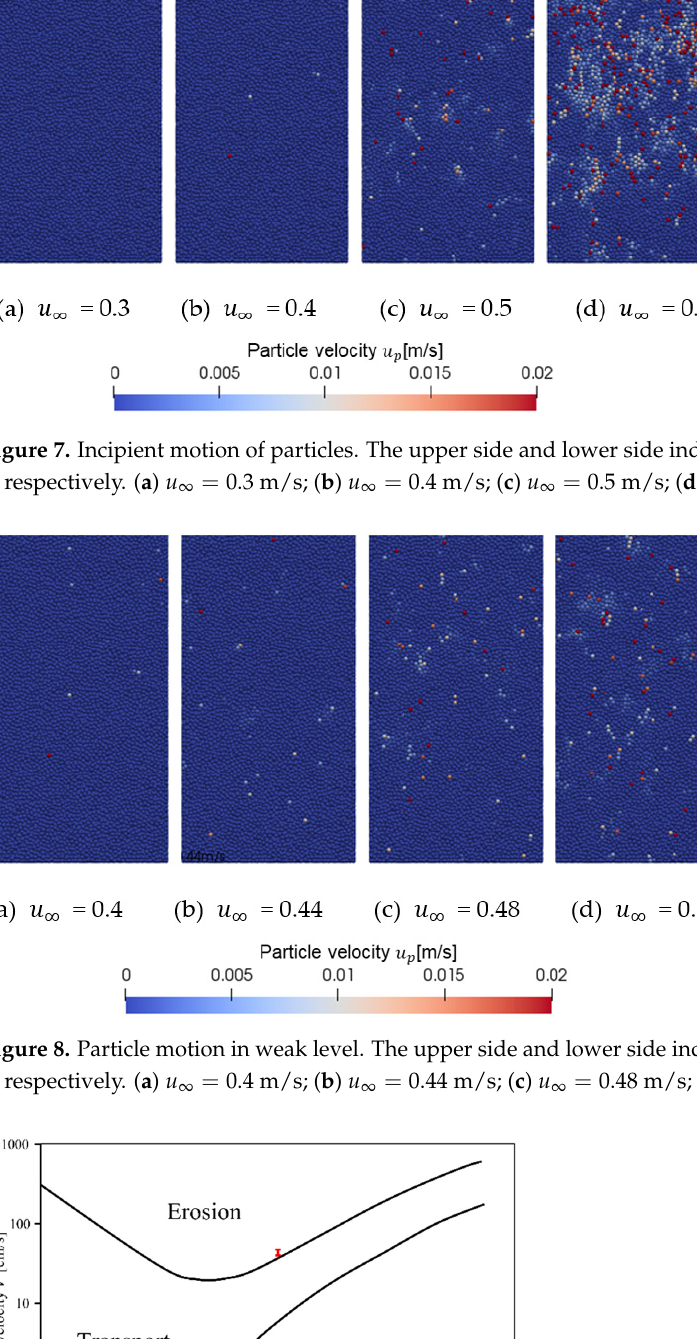
Figure 9. Simulation results for d p = 1 mm in the ranged from u ∞ = 0.4 to 0.48 m/s.